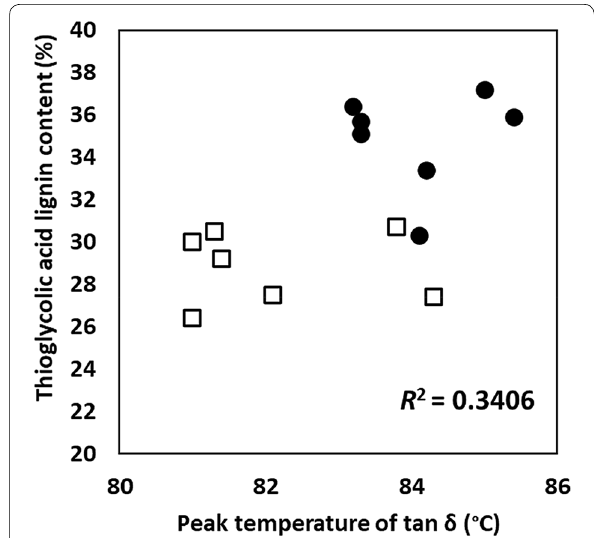
Fig. 8 Relationship between the peak temperature tan δ value and the lignin content of bamboo samples